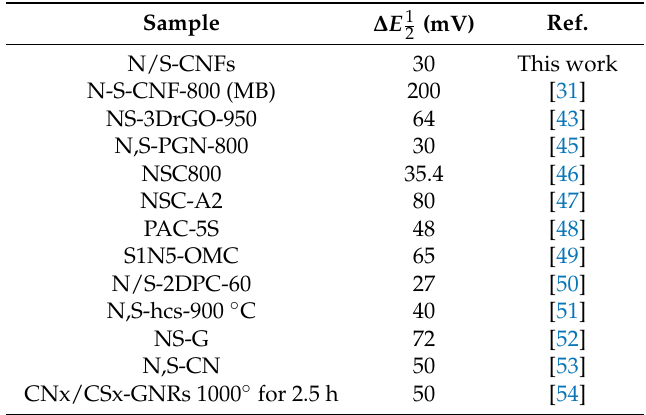
Table 1. The difference of half wave potential between the N/S-co-doped carbon-based elecrocatalyst and 20 wt % Pt/C for the ORR in 0.1 M KOH